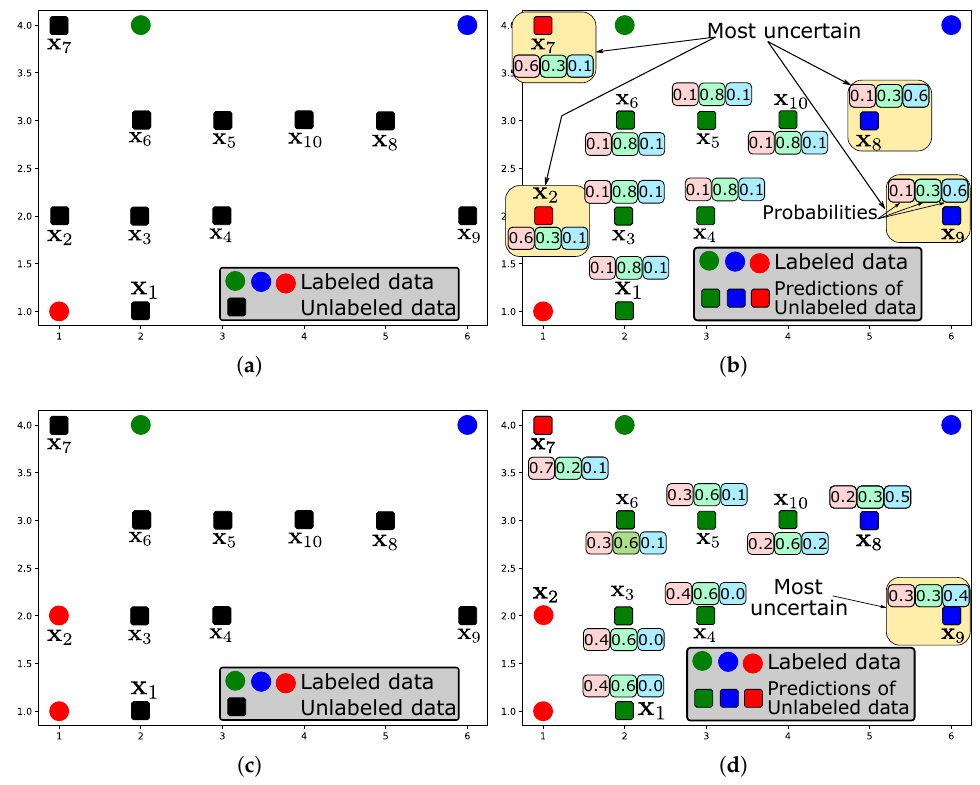
Figure 6. Illustration of the steps of how active learning queries points. ( a ) Labeled points are colored while the black squares represent the unlabeled points. After training a model on the initial labeled data in ( a ), the trained model is used to predict the class labels of the unlabeled points. ( b ) The predictions and the class probabilities of the unlabeled points and the most uncertain points. ( c ) One of the most uncertain points ( x 2 ) is queried and added to the labeled data. ( d ) The predictions and class probabilities of the trained model on the newly labeled points (i.e., after adding the new annotated